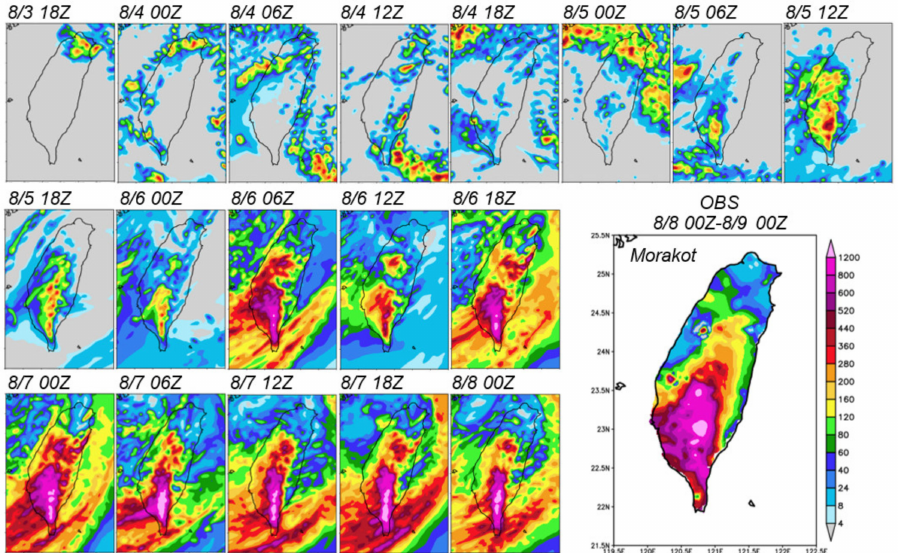
Figure 9. As in Figure 4, but for the observed 24-h rainfall (mm, enlarged panel), from 0000 UTC 8 to 0000 UTC 9 August, during TY Morakot (2009) and the predicted rainfall (mm) targeted for the same period by the time-lagged ensemble every 6 h (smaller panels), at initial times from 1800 UTC 3 to 0000 UTC 8 August as labelled. The same color scale (lower right) is used for all panels.